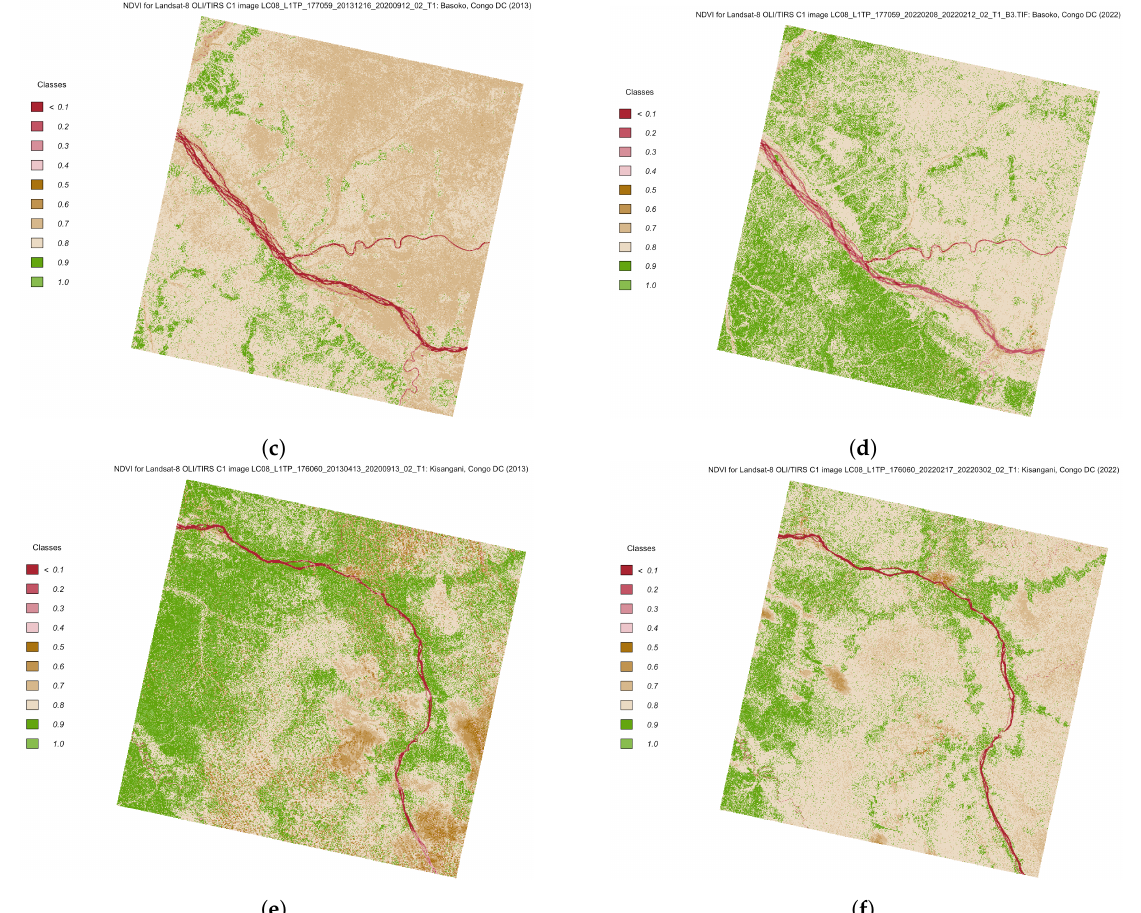
Figure 10. NDVI computed from 5 and 4 bands of the Landsat-8 OLI / TIRS scenes for years 2013 and 2022 for the three key areas: Bumba, Basoko, Kisangani. Mapping: RStudio. Source: authors. ( a ) Bumba region: 2013. ( b ) Bumba region: 2022. ( c ) Basoko region: 2013. ( d ) Basoko region: 2022. ( e ) Kisangani region: 2013. ( f ) Kisangani region: